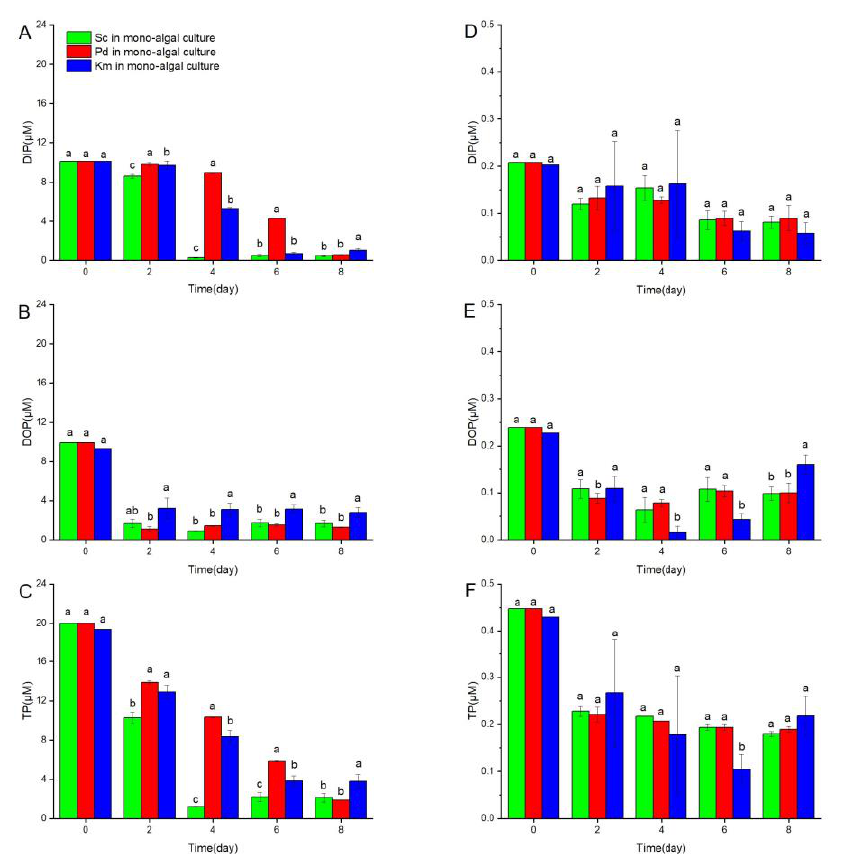
Figure 4. Concentration changes of DIP, DOP, and TP of P. donghaiense , S. costatum and K. mikimotoi in mono-algal culture under P-sufficient ( A – C )/deficient ( D – F ) conditions, respectively. The values are the mean ± S.D. ( n = 3), with the different lower-case letters indicate significant ( p < 0.05) differences among the different mono-algal cultures.